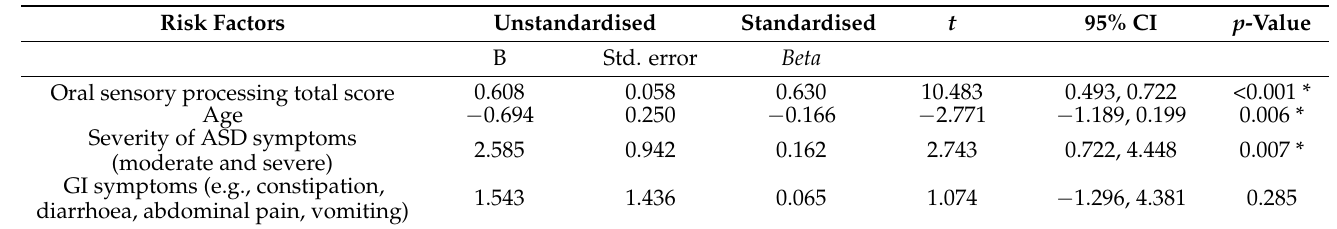
Table 6. Results of the multiple linear regression analysis determining the risk factors associated with atypical mealtime